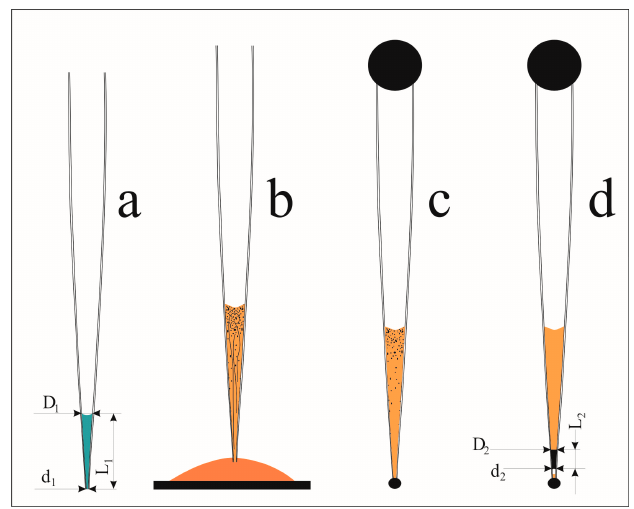
Figure 5. The final operations of UMCA: ( a ) determination of the volume of brine;( b ) a reagent kit for the precipitation of the corresponding component; ( c ) sealing of the capillary; ( d ) determination of the precipitate volume.